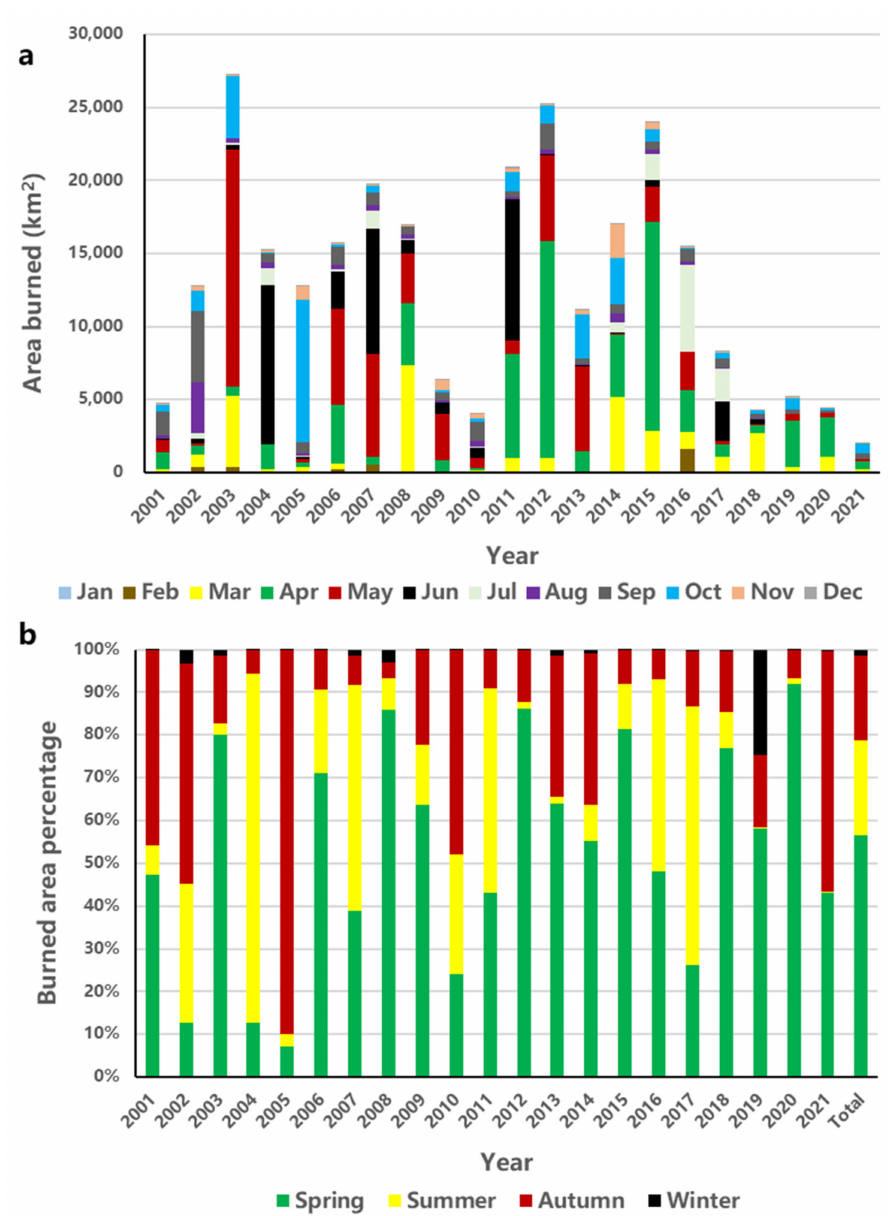
Figure 3. Annual ( a ) and seasonal ( b ) wildfire pattern in the Mongolian Plateau (MP) from 2001 to